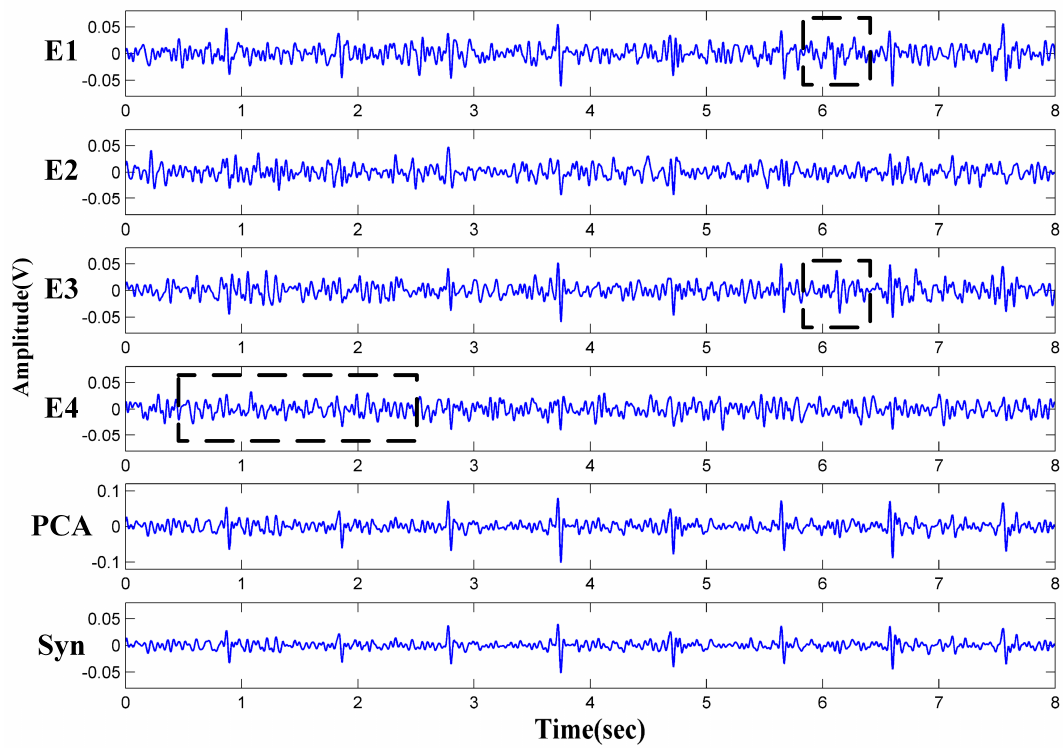
Figure 8. Measured ECG signals and synthetic results.